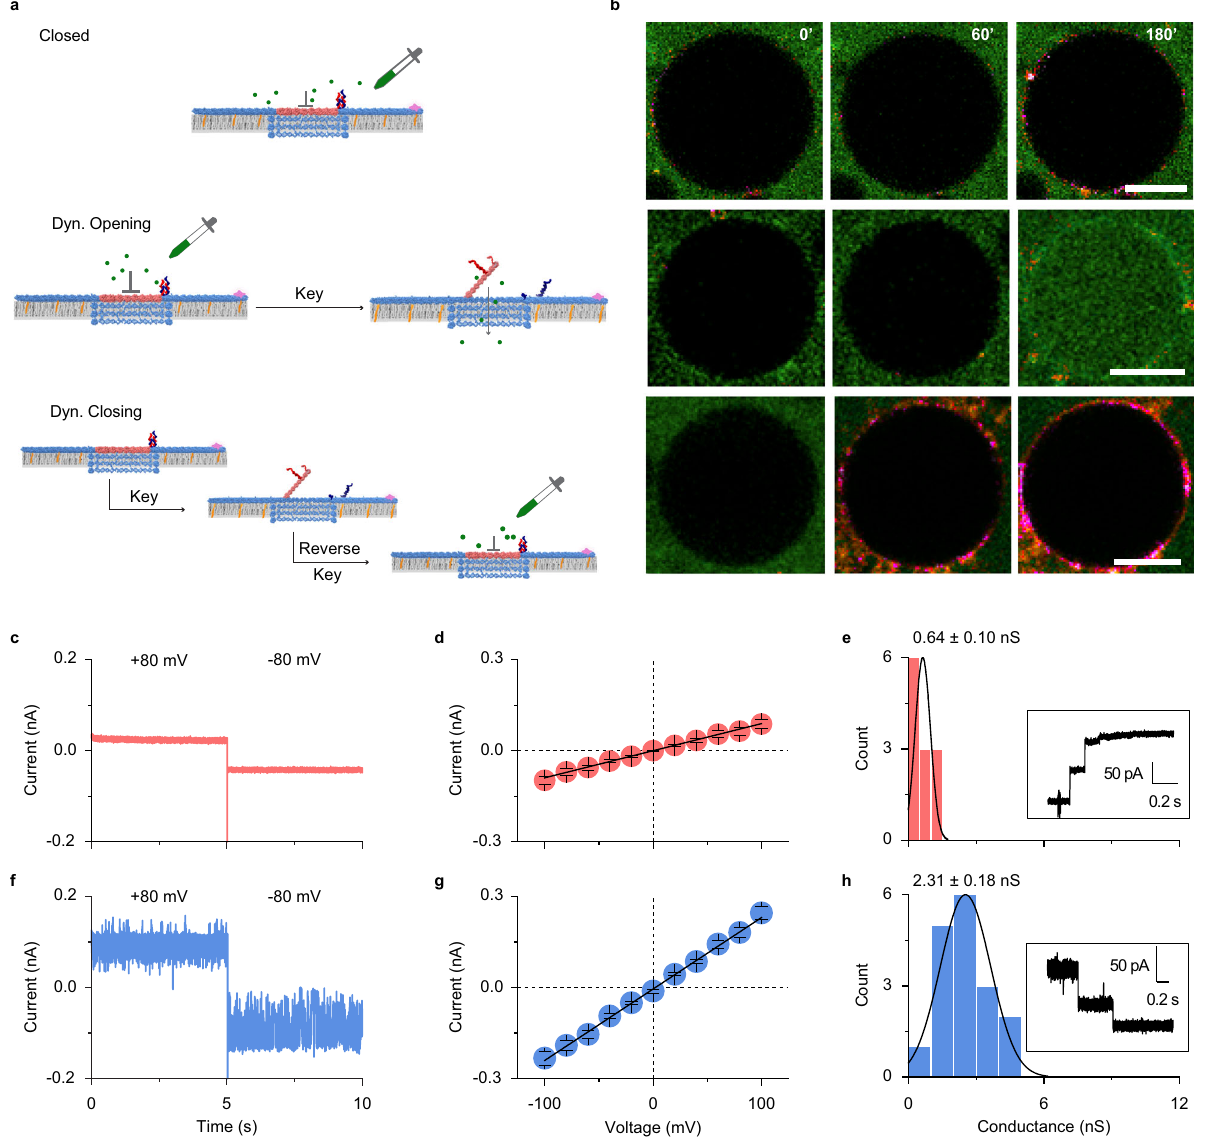
Fig. 4 Ligand-gated LGC dynamically controls cargo transport across the lipid bilayer. a GUV-dye-in fl ux assay scheme. b A time series of corresponding confocal images of GUVs incubated with cholesterol and Cy3-labeled LGC (magenta) and Atto633 dye (green), dropper represents the time point at which Atto633 dye was added. Top — closed lid LGC does not allow Atto633 dye in fl ux into GUV interior. Middle — dynamically opening the LGC lid with key results in the in fl ux of Atto633 dye into GUV. Bottom — separate experiment in which adding Atto633 to dynamically closed LGC does not lead to any dye in fl ux into GUVs, showing dynamic closing is effective. Scale bars: 10 μ m. The data were representative of n = 3 independent experiments. c Current trace of a single LGC-C channel inserted into a planar DPhPC membrane. The trace was recorded at a voltage of + 80 mV for the fi rst 5 s, after which the potential was is switched to − 80 mV. d Current-voltage (IV) plot showing average current of 12 individual insertions ± standard error of the mean of LGC- C at membrane potentials ranging from − 100 to + 100 mV in 20 mV steps. e Conductance histogram of 12 individual insertions of LGC-C obtained at − 20 mV. Inset shows an example trace on the transition from closed-lid pore to open-lid after addition of 15 nM key. f Current trace of a single LGC-N